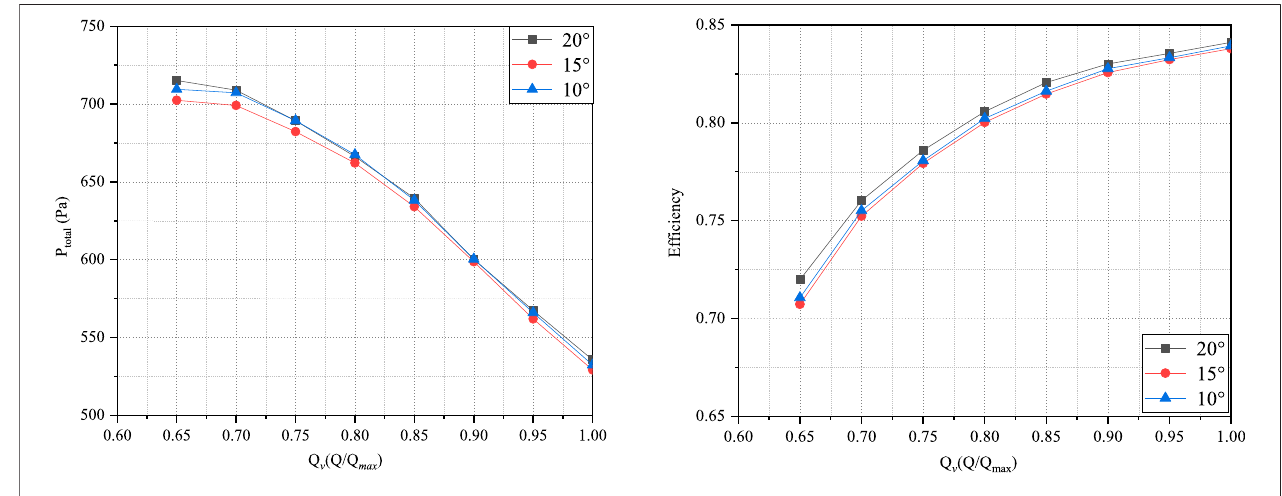
FIGURE 10 | Performance curves of forward-swept blades with different forward-sweep angles.